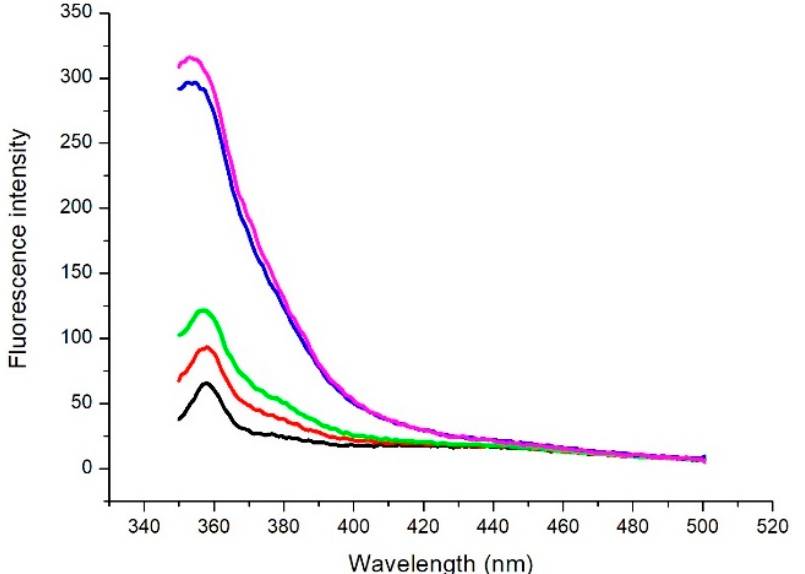
Figure 3. Emission spectrum of a solution of laccase and catechol ([laccase] = 8 µ g/mL and [catechol] = 0.4 mM). Measurements were performed at various times: immediately after catechol addition (t0) (black line), 5 min (red line), 10 min (green line), 50 min (blue line), and 80 min (purple line) after catechol addition.